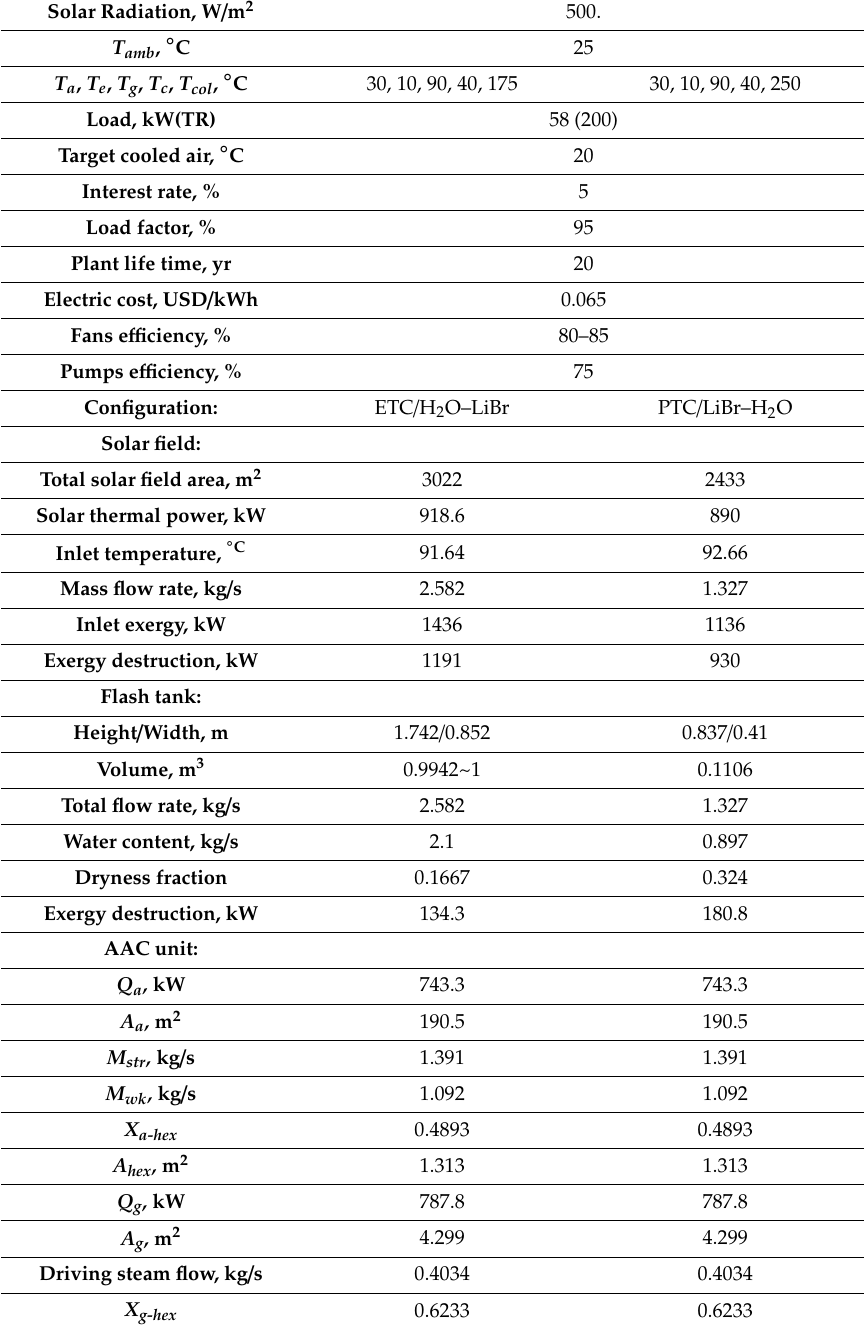
Table 2. Data results based on a 200 TR load case